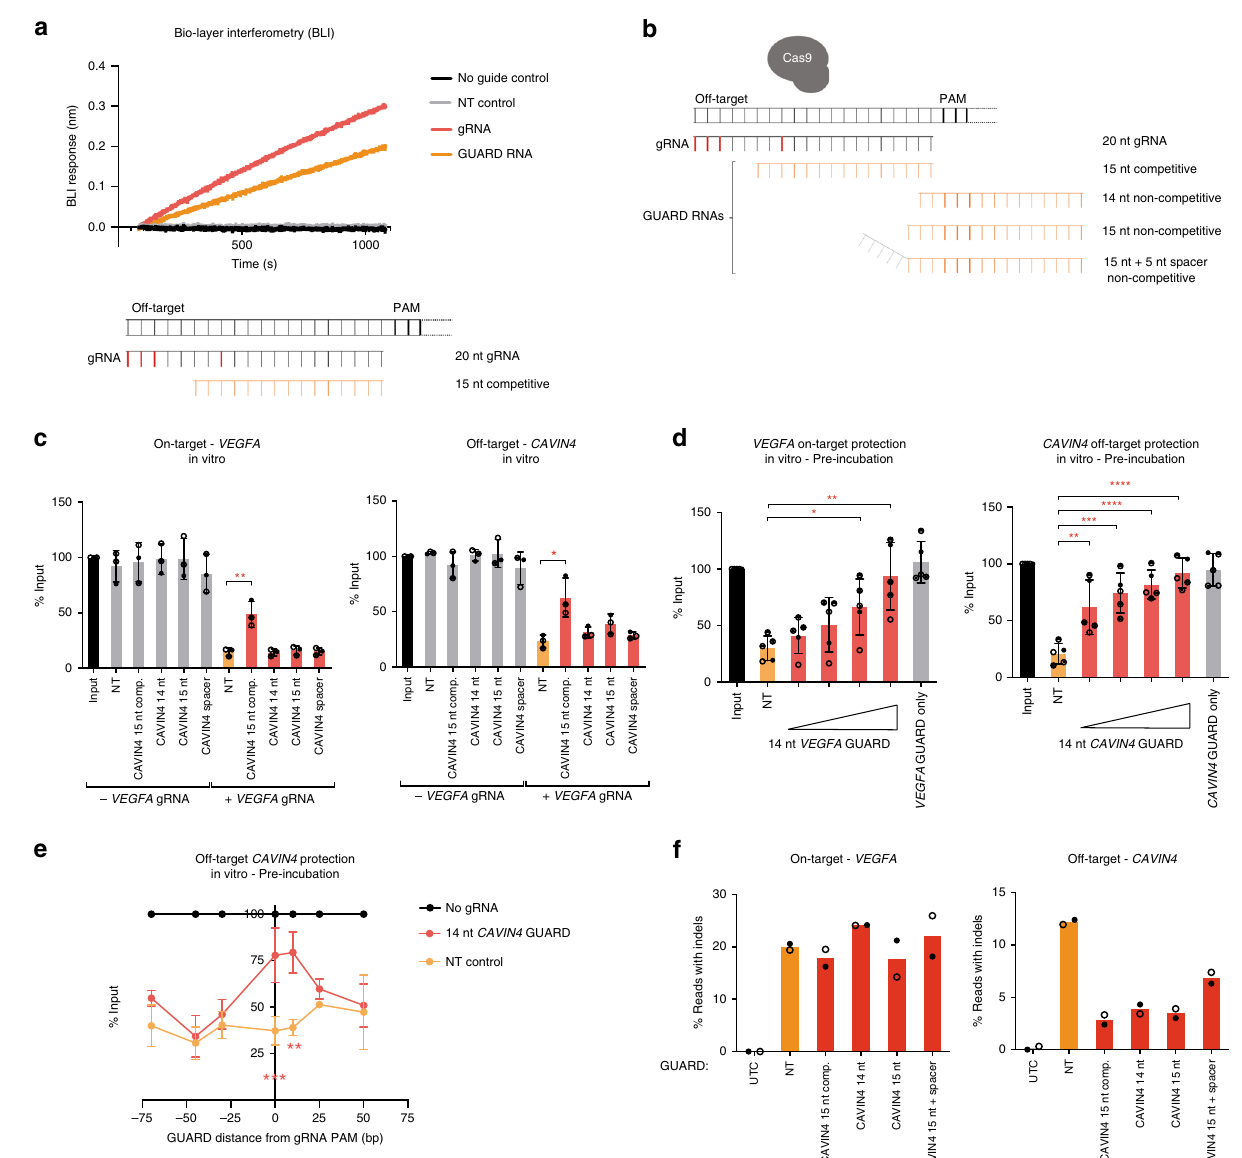
Fig. 2 GUARD RNAs reduce Cas9 off-target cleavage activity without affecting on-target editing. a Bio-layer interferometry (BLI) analysis of binding kinetics for dead Cas9 ribonucleoprotein complex to an immobilised biotinylated DNA substrate. Cas9 was precomplexed with tracrRNA and (NT) non- targeting control gRNA; (gRNA) 20-nt VEGFA gRNA with 4 mismatches; (GUARD RNA) a 15-nt GUARD RNA targeting the off-target site or no guide RNA. b CRISPR GUARD design. Schematic showing GUARD RNAs designs. Variation in length (14-nt versus 15-nt) and protospacer positioning likely in fl uence binding energy and competition with the on-target gRNA (i.e., competitive/overlapping, non-competitive/proximal). Mismatches in the gRNA are shown in red. RNA bases overlapping the gRNA PAM are shown in bold. c Competition between on-target gRNA and GUARD RNA can be reduced by proximal positioning. On-target ( VEGFA ) and off-target ( CAVIN4 ) DNA abundance was measured by qPCR following an in vitro Cas9 DNA cleavage assay. The corresponding GUARD RNA was added at a molar ratio of 5:1 to the VEGFA on-target gRNA (100 nM to 20 nM). d GUARD RNAs are more effective at blocking Cas9-mediated DNA cutting with pre-incubation in vitro. On-target ( VEGFA ) and off-target ( CAVIN4 ) DNA abundance was measured by qPCR following an in vitro Cas9 DNA cleavage assay, with a 30 min pre-incubation with GUARD RNAs and Cas9, before addition of the on-target gRNA and Cas9. Increasing molar ratios of GUARD RNA to the VEGFA on-target gRNA were used (10:10, 20:10, 50:10, 100:10 nM). e GUARD RNAs are effective in blocking Cas9-mediated DNA cleavage of off-target sites within a 10 bp window of the gRNA PAM. Synthetic DNA fragments containing the VEGFA gRNA off-target site CAVIN4 positioned progressively further away from the GUARD RNA binding site were quanti fi ed by qPCR following an in vitro Cas9 DNA cleavage assay (50:10 nM GUARD RNA to gRNA ratio). f CRISPR GUARD is effective at blocking off-target editing in cells. Indel rates from NGS of amplicons from Cas9-expressing HEK293 cells transfected with VEGFA gRNA and multiple GUARD RNA designs for protection of the CAVIN4 proximal off- target site (25:25 nM GUARD RNA to gRNA ratio). Data represent the mean of two ( f ) independent experiments, or the mean ± SD of three ( c, e ) or fi ve ( d ) independent experiments with symbols representing each replicate. For a , data are representative of two independent experiments. NT non-targeting gRNA, UTC untransfected control. Unpaired, two-tailed student ’ s t -test. For c , * P = 0.0208, ** P = 0.0083. For d , * P = 0.0164, ** P = 0.0021 ( VEGFA ) and ** P = 0.007 ( CAVIN4 ), *** P = 0.0003, *** P < 0.0001. For e , ** P = 0.0041 and *** P = 0.0001. Source data are provided as a Source Data fi